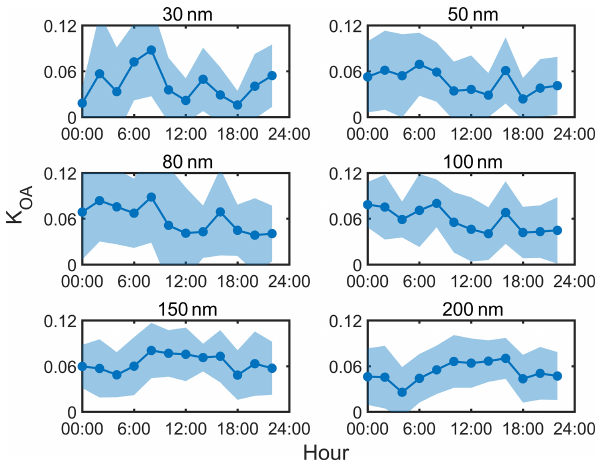
Figure 6. The average (solid line) and standard deviation (shaded area) diurnal variation in κ OA at different particle